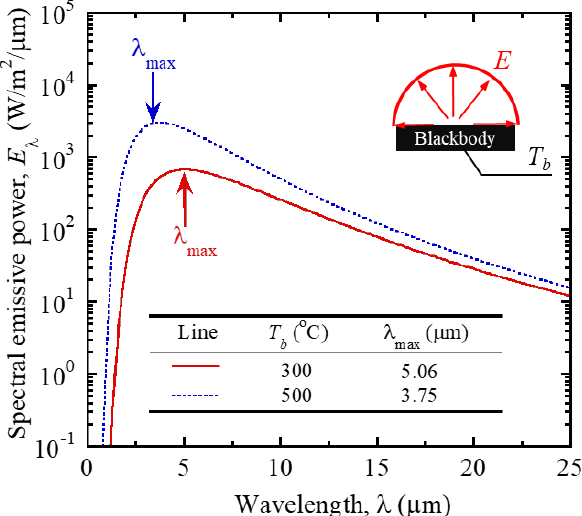
Figure 4. Spectra of spectral emissive power ( E λ ) from a blackbody at temperature T b = 300 ◦ C and T b = 500 ◦ C. The wavelength ( λ max ) corresponding to peak of each spectrum is also listed.